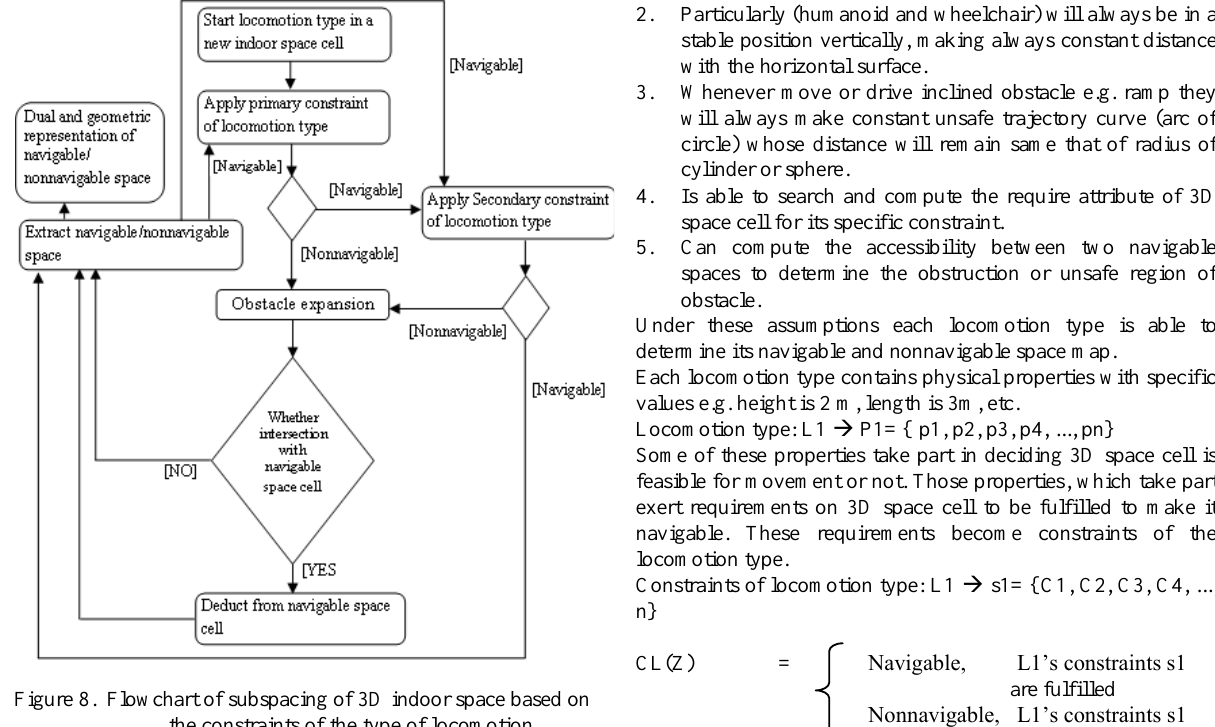
Figure 8. Flowchart of subspacing of 3D indoor space based on the constraints of the type of locomotion. The attributes of each space cell contain semantics, topology or geometric information related to cell e.g. feature type, width, volume,